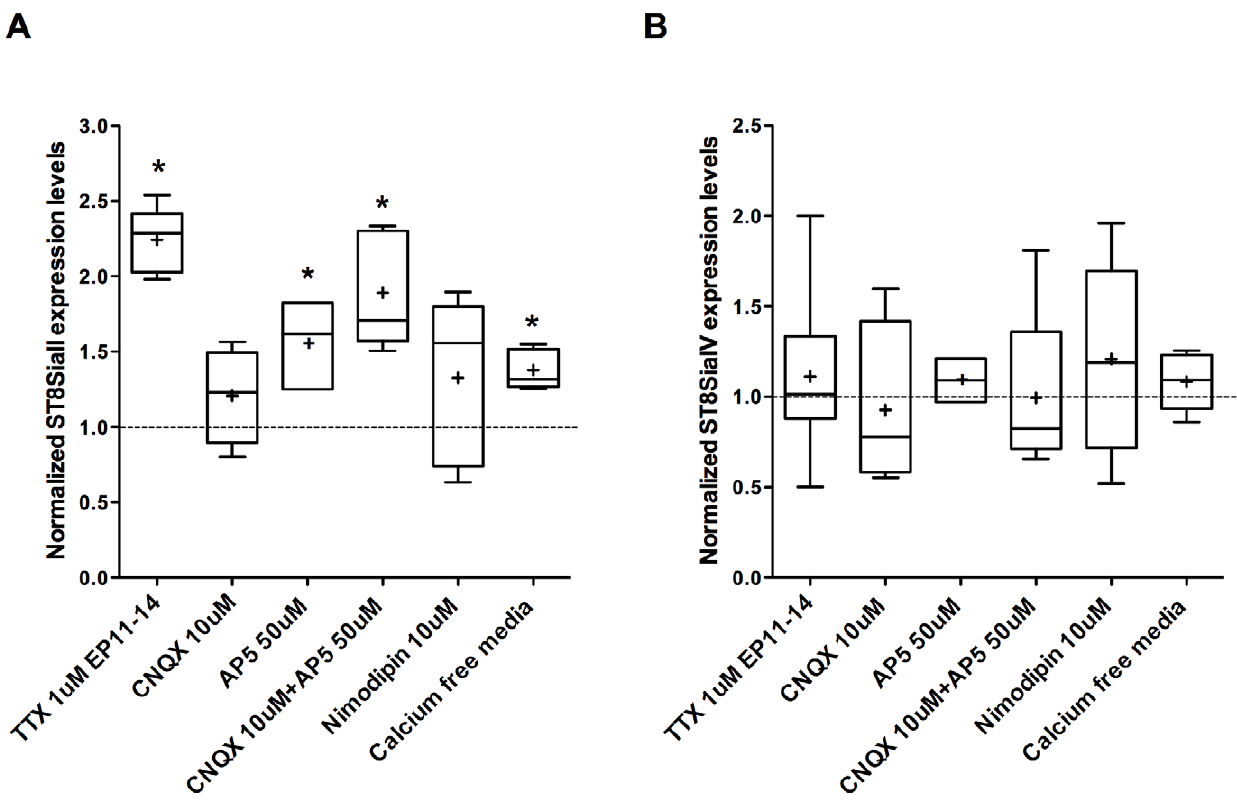
Figure 4. NMDA-mediated excitation regulates ST8SiaII mRNA expression levels, in part through Ca 2 + dependent mechanisms. (A) ST8SiaII mRNA levels are significantly higher in organotypic cultures treated from EP11-14 with AP5, an inhibitor of NMDA receptor activation, compared to control values. This effect is potentiated by the simultaneous blockade of NMDA and AMPA receptor, via CNQX + AP5 treatment (Two- Way ANOVA, by post hoc Dunn’s test, *p , 0.05). Incubating organotypic cultures with Ca 2 + free media causes a small but significant increase in STX expression levels compare to controls (*p , 0.05). Blockade of L-type VGCC via nimodipine application does not significantly affect ST8SiaII mRNA levels (p . 0.05). (B) None of these treatments affects ST8SiaIV mRNA levels (p . 0.05). Graphs are plotted as explained in Figure